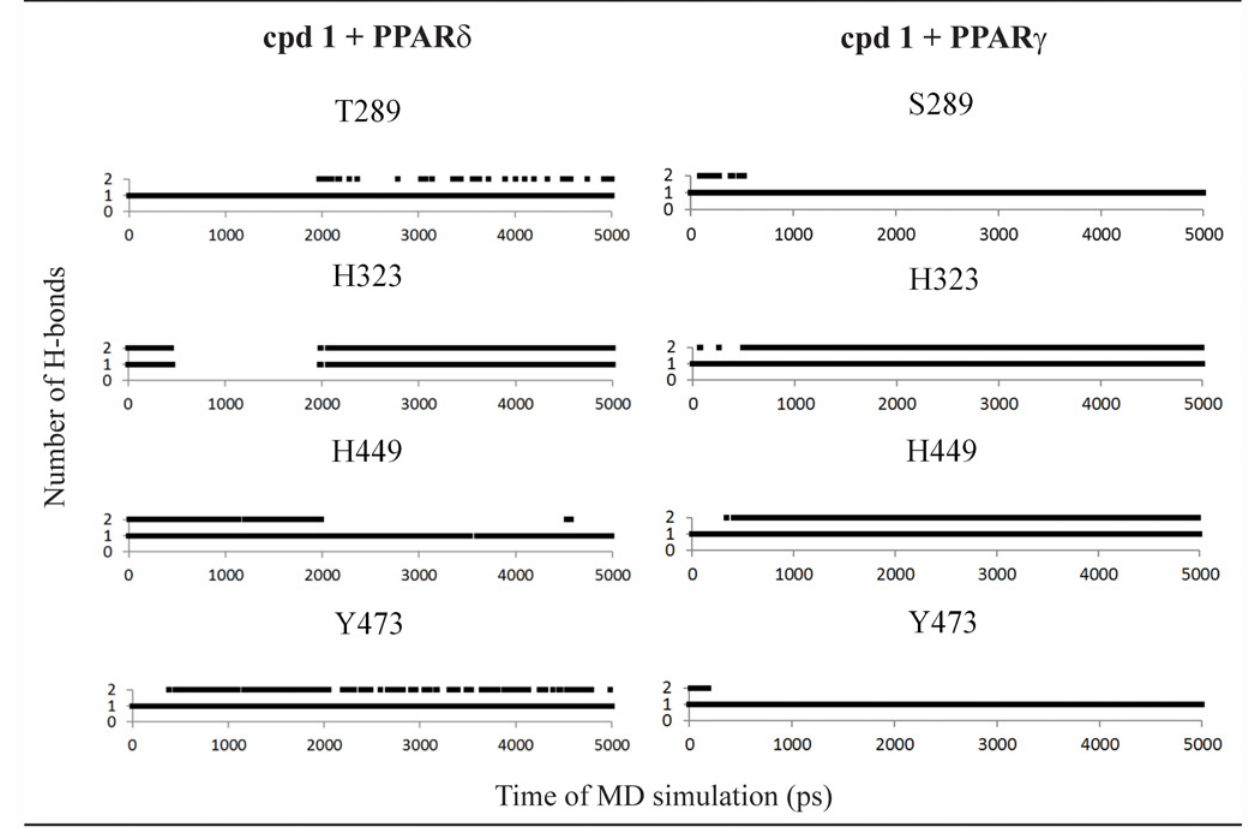
Fig 3. Hydrogen bonds diagram between compound 1 and polar residues of PPAR δ and PPAR γ . Black squares indicate the presence of H-bonds and white ones correspond to the absence of